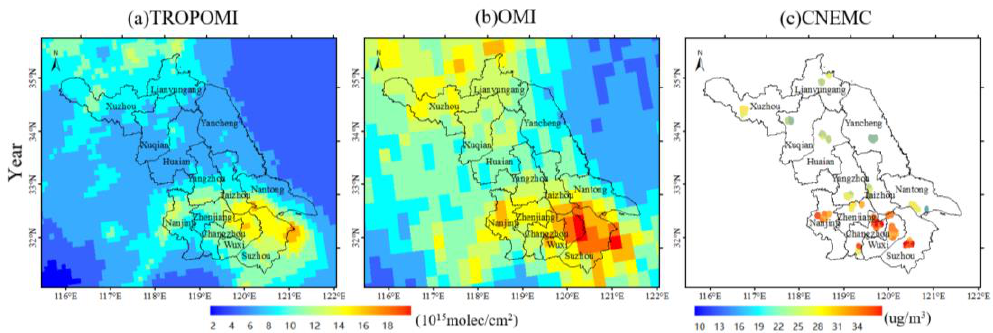
Figure 3. Annual averaged NO 2 in Jiangsu from ( a ) TROPOMI, ( b ) OMI and ( c ) CNEMC .